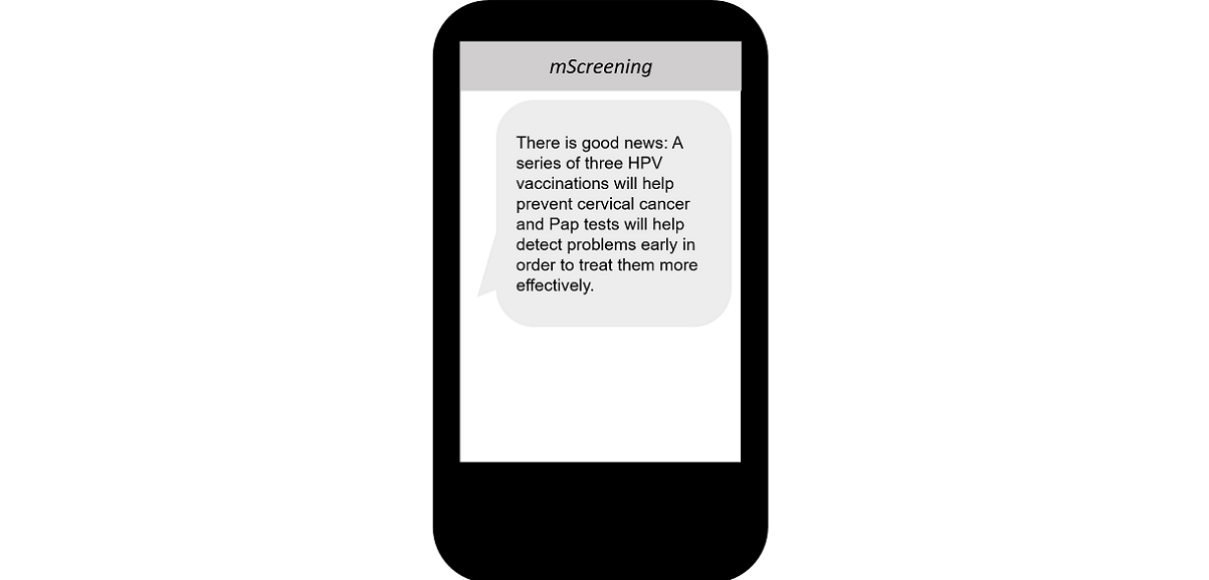
Figure 3. Mobile screening message example: focused on enhancing